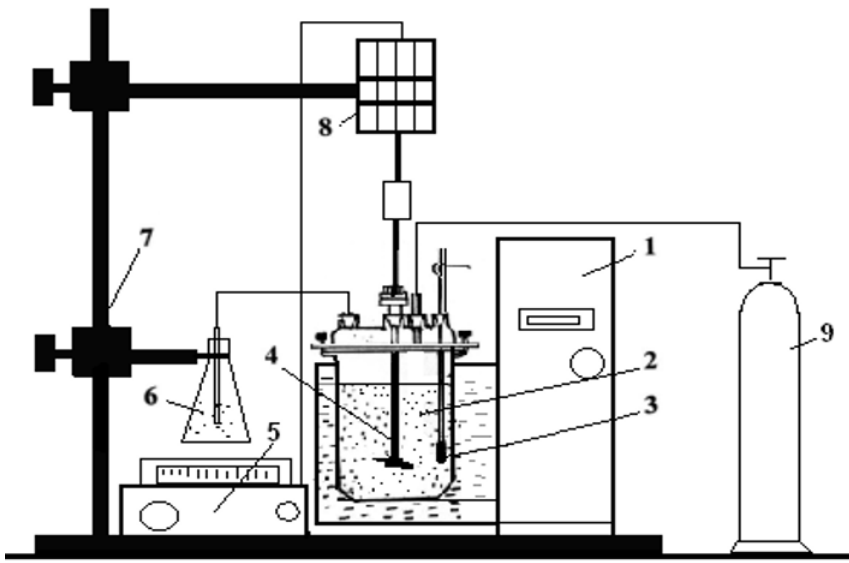
Figure 1. A schematic drawing of the experimental set-up: 1-Ultrathermostat, 2- reactor with stirring, 3-thermometer, 4-stirrer, 5-tachometer, 6-final gas neutralization vessel , 7-fixing support, 8-mixer motor, 9- sulfur dioxide